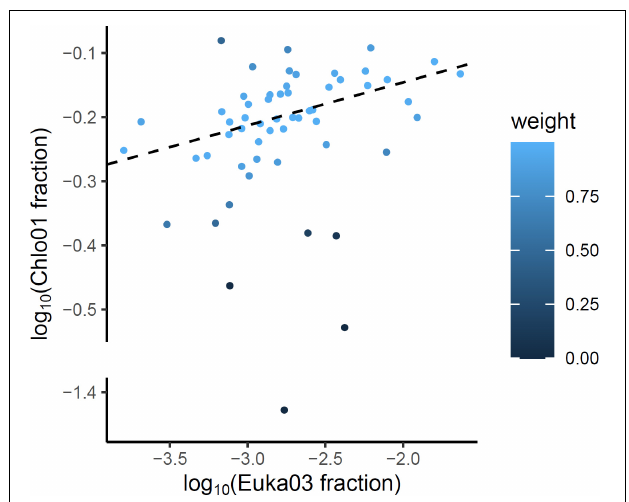
FIGURE 3 | On a logarithmic scale, the relative frequencies of Chlorophyta reads estimated by the two markers Chlo01 and Euka03 are correlated. The linear model (dotted line) was estimated using an iteratively reweighted least squares procedure (IRLS) to underweight the influence of the few outliers PCRs. The blue scale indicates the weight associated to each PCR after the convergence of the